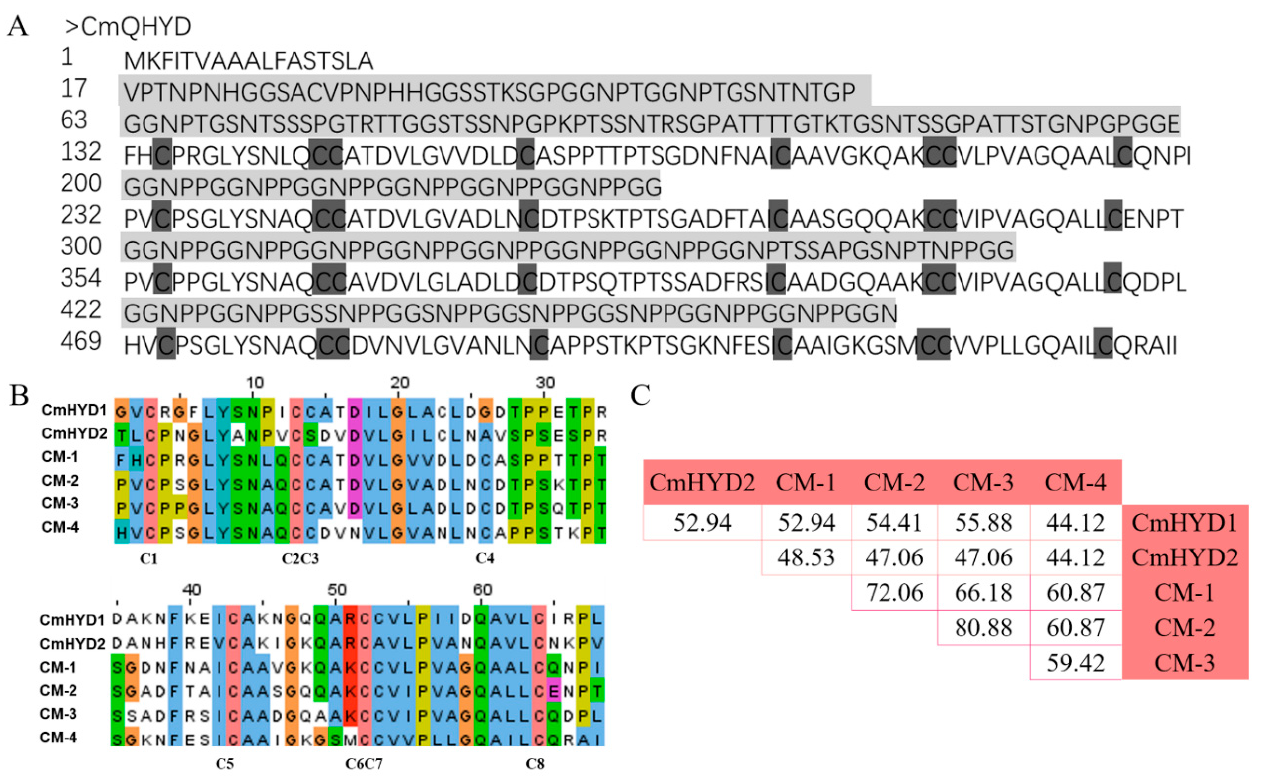
Figure 5. Deduced peptide sequences of CmQHYD. ( A ) The amino terminus was a glycine-rich region and the intervening sequences of four hydrophobin units are highlighted in grey. The conserved cysteine residues of the four hydrophobin domains are shown in black. ( B ) Alignment of the deduced peptide sequences of the four hydrophobin units and two class II hydrophobin proteins, CmHYD1 and CmHYD2. Conserved amino acids are shown in different colors. The alignment was constructed using the Jalview 2.11.0 (SIB Swiss Institute of Bioinformatics, Lausanne, Switzerland) program. CM-1~4 represents the four hydrophobin units of CmQHYD, respectively. ( C ) The percentage of identity between four hydrophobin units of the CmQHYD and CmHYD1 and CmHYD2. The identity referred to the proportion of identical residues at the same site between two sequences. Table 2. The multi-domain hydrophobin proteins found in fungi of Cordycipitaceae and Clavicipitaceae.